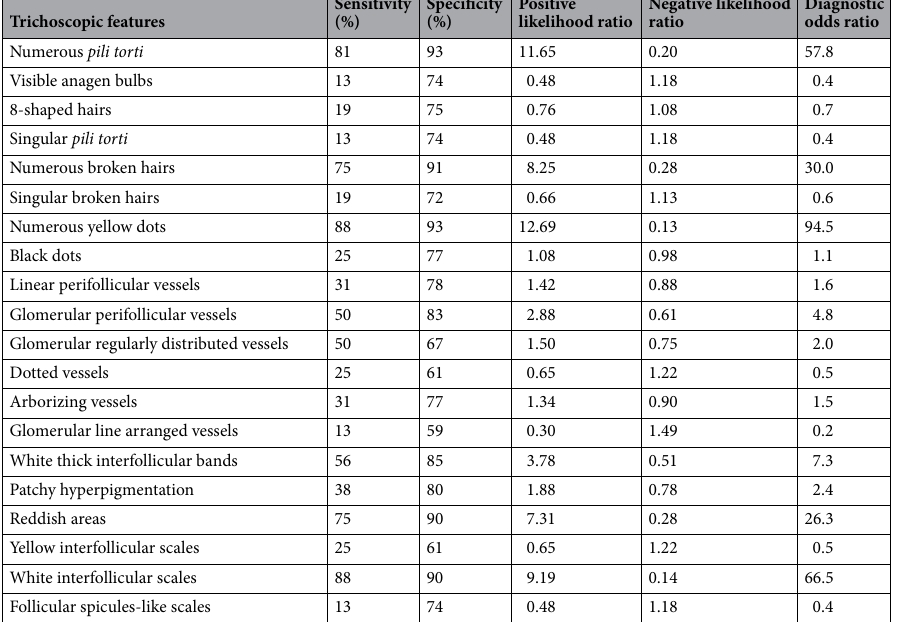
Table 2. Sensitivity, specificity, positive and negative likelihood ratio and diagnostic odd ratio of trichoscopic criteria for erythrodermic cutaneous T-cell lymphoma vs erythrodermic psoriasis and erythrodermic atopic